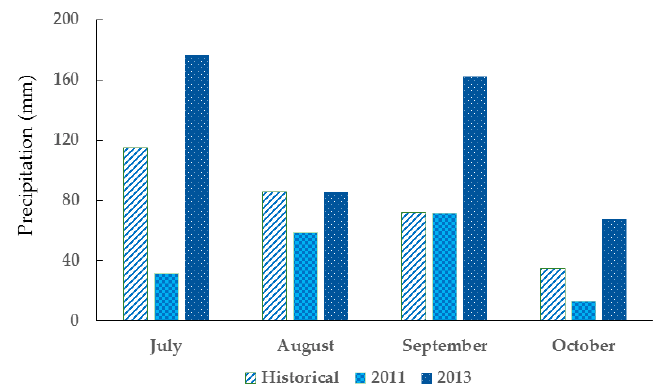
Figure 1. Precipitation during the 2011 and 2013 growing seasons (July–October) of dry bean ( Phaseolus vulgaris L.) in Pabellon de Arteaga, Aguascalientes, Mexico.